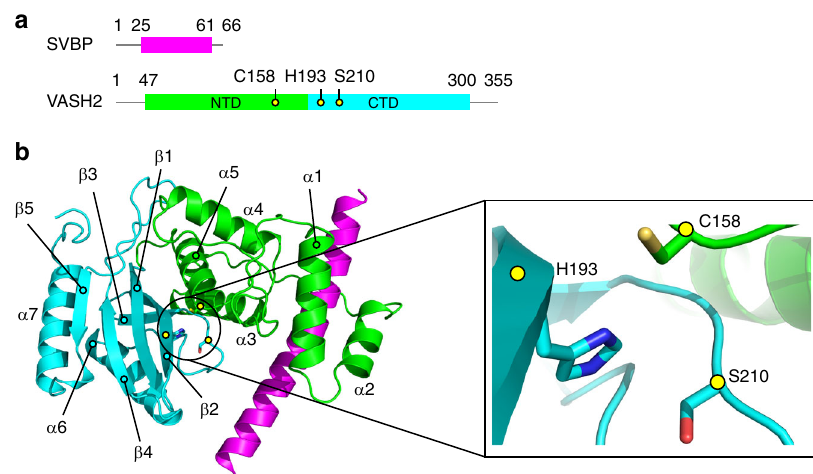
Fig. 1 Structure of the VASH2/SVBP heterodimer. a Schematic depiction of VASH2 and SVBP. The Cys-His-Ser catalytic triad is highlighted in yellow circles. b Cartoon representation of the VASH2/SVBP structure. VASH2 NTD is colored green, CTD is colored cyan, and SVBP is colored magenta. C158, H193 and S210 are shown in stick representation. The α -helices and β -strands are numbered and